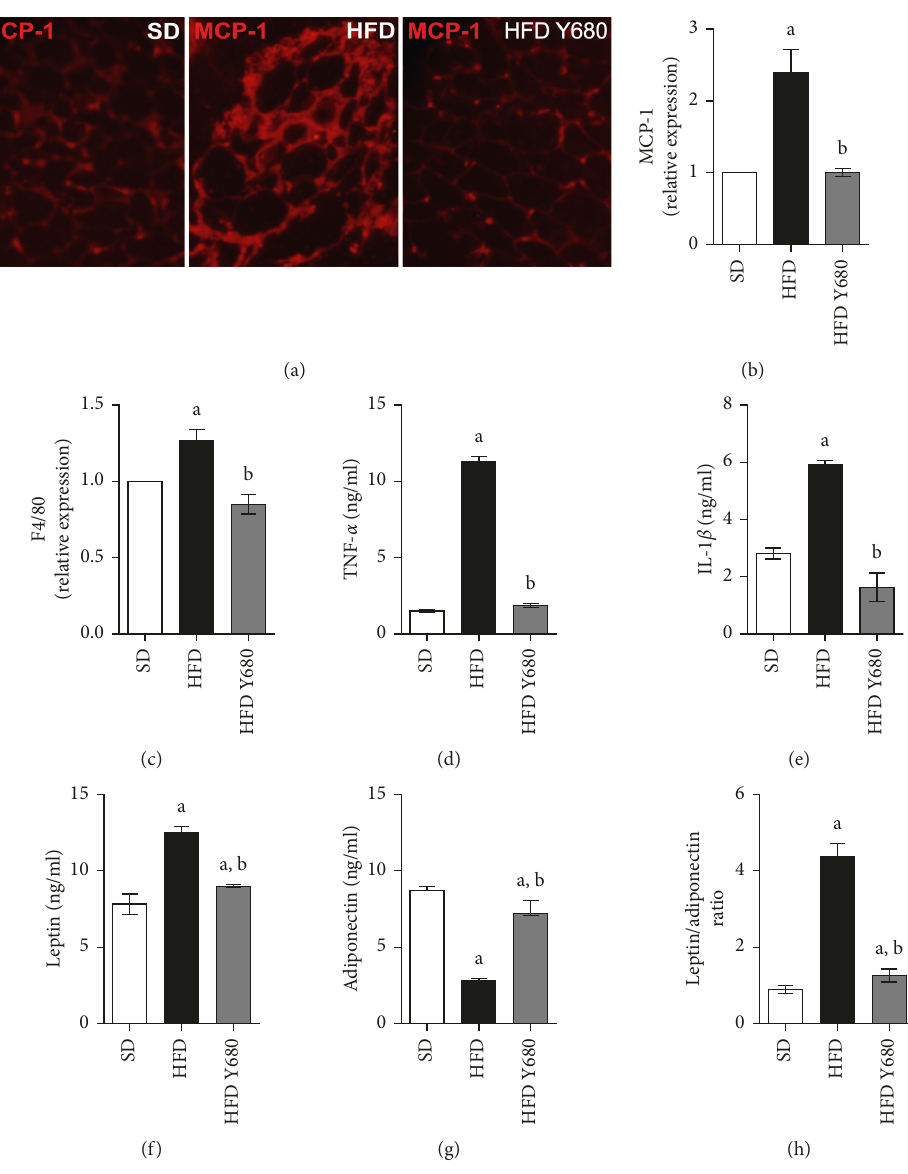
Figure 4: Effects of yacon flour on inflammatory markers in HFD-fed rats. (a) Representative sections of visceral fat stained with MCP-1 from rats fed standard diet (SD) or high-fat diet (HFD) supplemented or not with yacon flour (680 mg FOS/kg body weight: HFD Y680) (original magnification 126X). (b) Staining score, assigned to each section according to the MCP-1 levels. (c) F4/80 protein expression of in visceral fat by western blotting. (d, e) Serum TNF- α and IL-1 β concentrations determined by ELISA. (f, g) Plasma leptin and adiponectin concentrations. (h) Leptin/adiponectin ratio. Data are mean